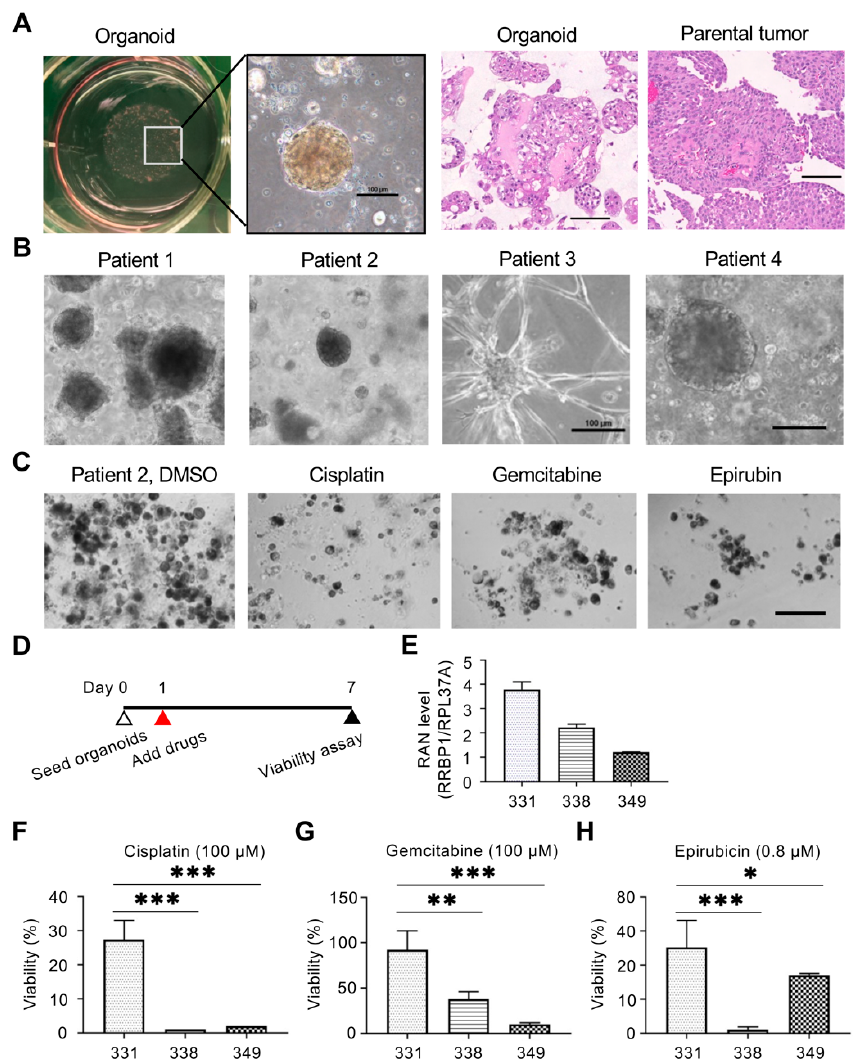
Figure 6. RRBP1 shows potential for drug combination therapy. ( A ) UTUC patient-derived organoid culture system mimics the cell morphology similar to the parental tumor. The cells were extracted from the patient’s tumor and then embedded in Matrigel to establish organoid cultures. HE staining was used to detect sections from the parental tumor and organoid. Scale bar = 100 µm. ( B ) Representative images for the four primary UTUC organoids. The organoids were constructed from the patient’s tumor and cultured for two weeks. Scale bar = 100 µm. ( C ) The organoids were treated with 100 µM drugs for 7 days. Scale bar = 100 µm. ( D ) The organoids were seeded overnight and then treated with drugs for 7 days. The viability of organoids was determined by the 3D organoid viability assay. ( E ) The levels of RRBP1 mRNA in three organoids were measured. Data represent the mean ± SD. ( F – H ) The level of RRBP1 mRNA was correlated to the cytotoxicity effect of drugs in organoids. The organoids were treated with 100 µM cisplatin, gemcitabine, and 0.8 µM epirubicin for 7 days, and then the viability was determined. Data represent the mean ± SD. (* p < 0.05; ** p < 0.01; *** p < 0.001.) Statistical analysis was performed by using one-way ANOVA with Dunnett’s test.